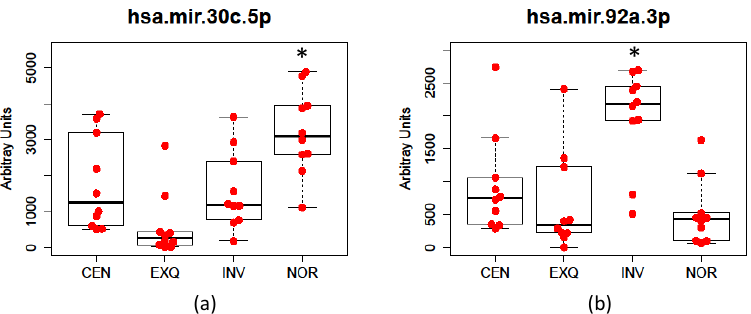
Figure 3. ANOVA analysis of the performance of the different methods for ( a ) hsa-mir-30c-5p and ( b ) hsa-mir-92a-3p detection. Note: in panel ( a ), NOR is significantly different from the other treatments, while in panel ( b ) INV is different from the rest of the treatments ( p < 0.05, by post-hoc comparisons using Bonferroni correction).